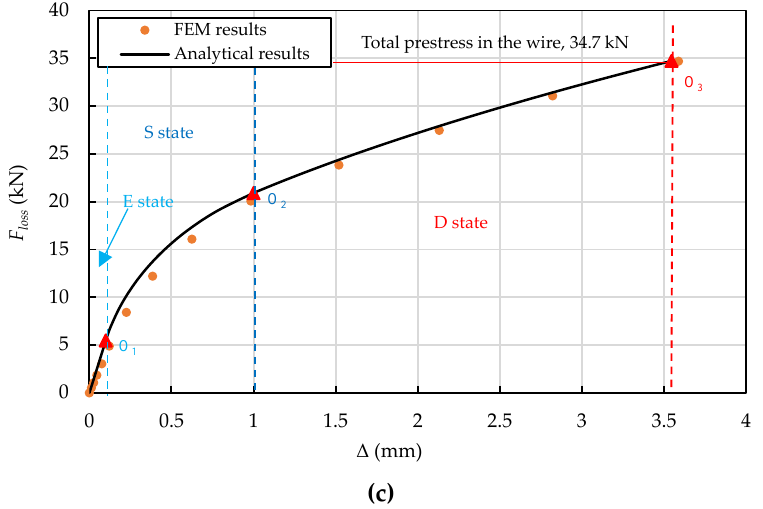
Figure 10. Comparisons of ( a ) the stress in the prestressing wire, ( b ) interfacial shear stress, and ( c ) prestress loss – displacement curve between analytical and FEM predictions.